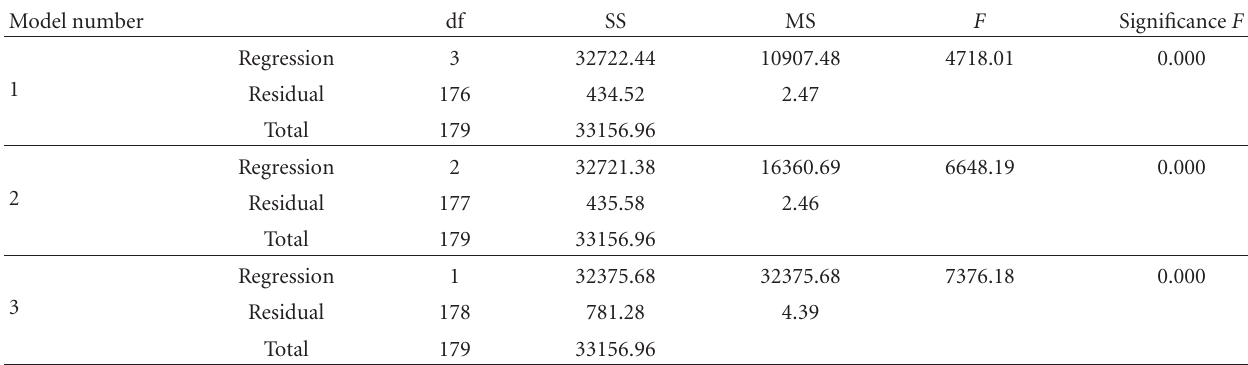
Table 4: ANOVA results for the suggested models fitted using monthly average meteorological data for Kuwait from 1993 to 2006 (calibration range).